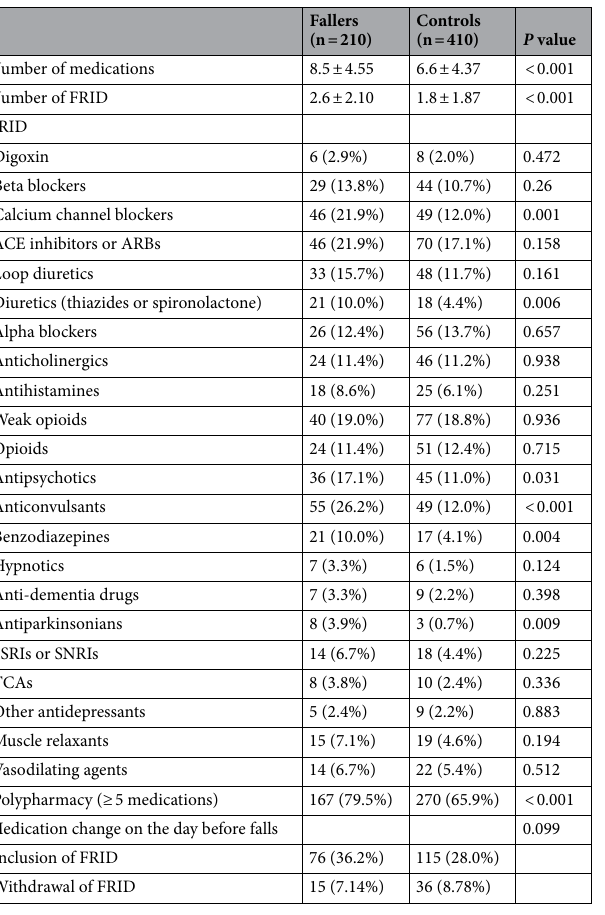
Table 3. Fall risk-increasing drugs prescribed to fallers and matched controls. Data are means (standard deviation) or frequencies (percentage), as appropriate. ACE inhibitors, angiotensin-converting enzyme inhibitors; ARBs, angiotensin II receptor Antagonists; FRID, fall risk-increasing drugs; SSRIs, selective serotonin reuptake inhibitors; SNRIs, serotonin norepinephrine re-uptake inhibitors; TCAs; tricyclic